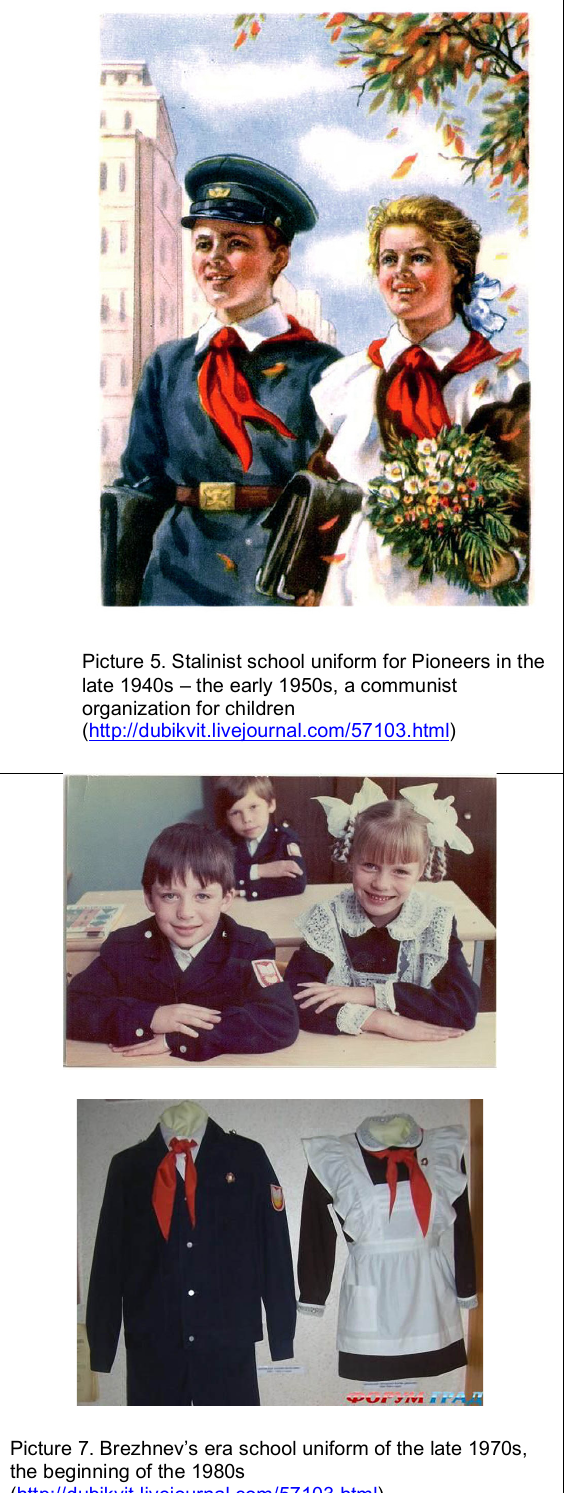
Picture 7. Brezhnev’s era school uniform of the late 1970s, the beginning of the 1980s